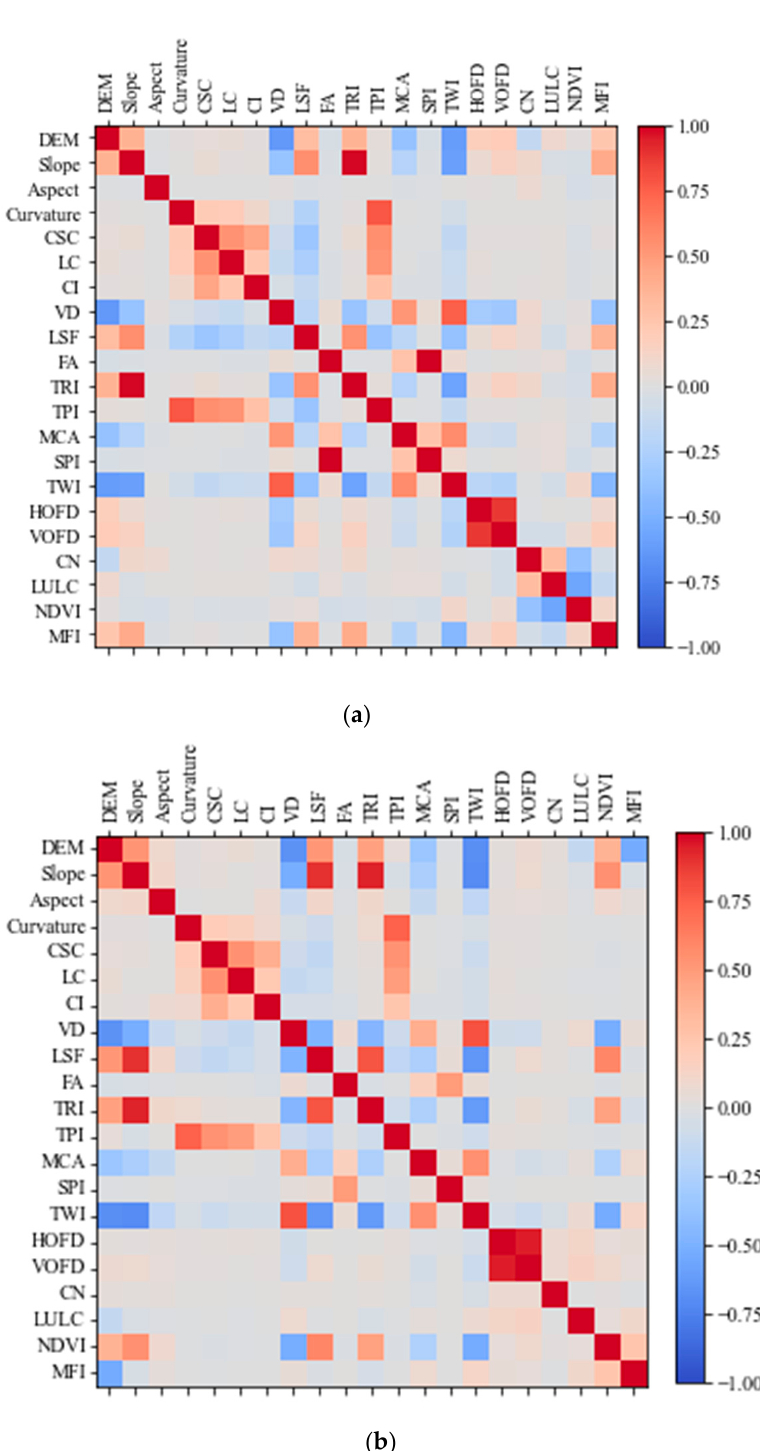
Figure 6. Pearson correlation coefficient between all variables. ( a ) Karun Basin, and ( b ) Gorganrud Basin.